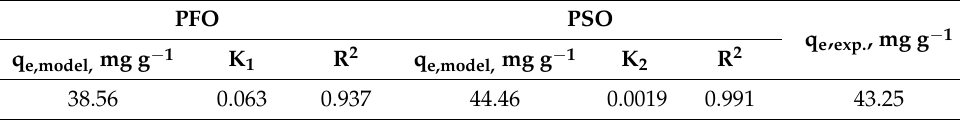
Table 1. Parameters of PFO and PSO kinetic models for U(VI) sequestration onto PGO–Gd. PFO